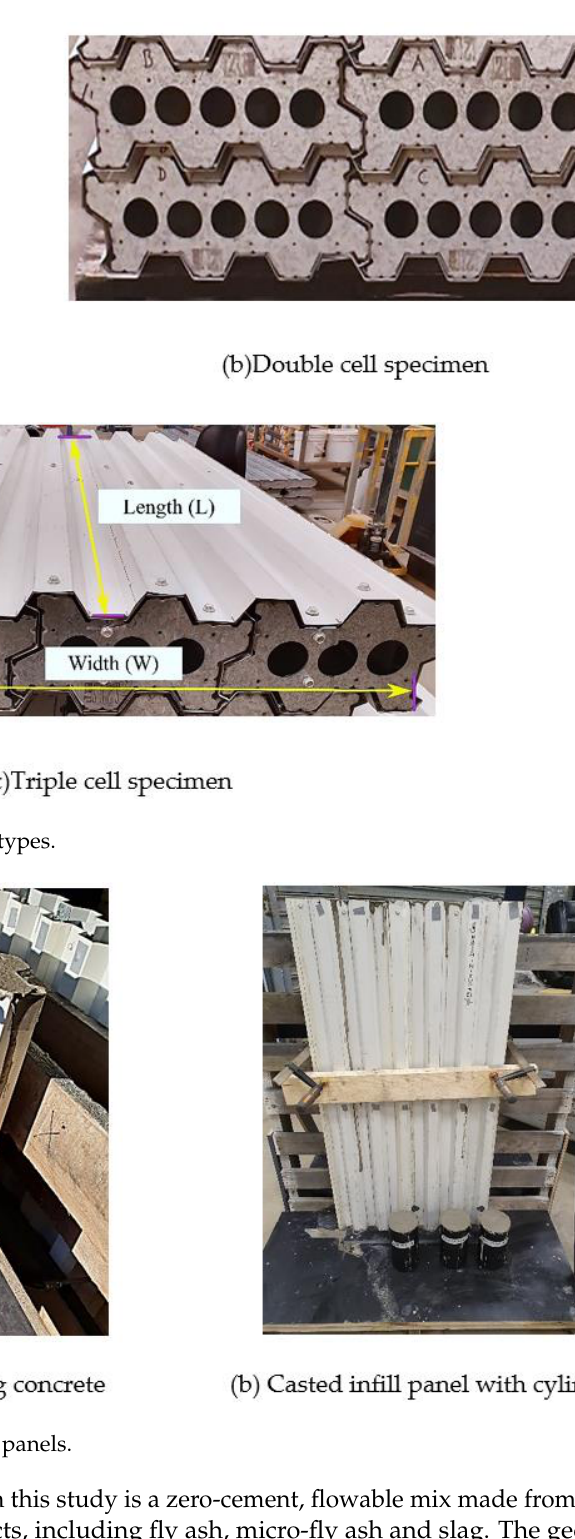
Figure 3. Casting of panels.